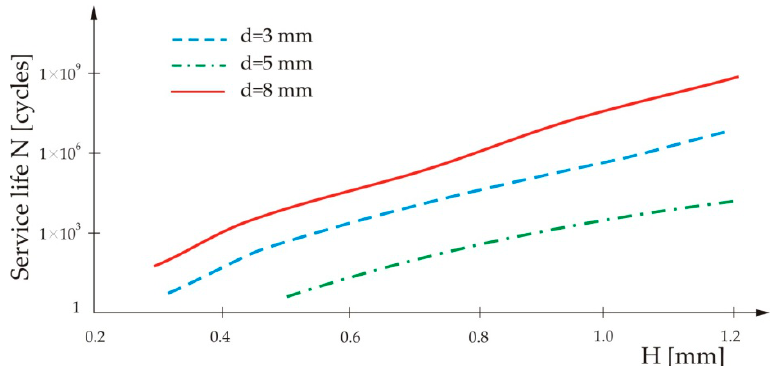
Figure 7. Influence of loading on the service life of the spot-weld for three different nugget diameters .